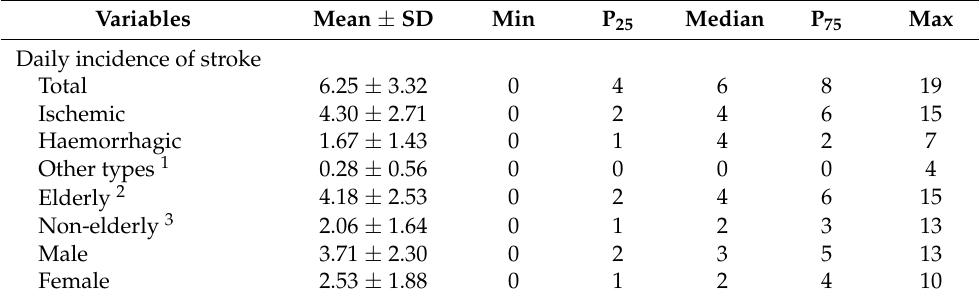
Table 1. Descriptive statistics for daily incidence of stroke, air pollutant concentrations, and meteoro- logical factors in Enshi city,